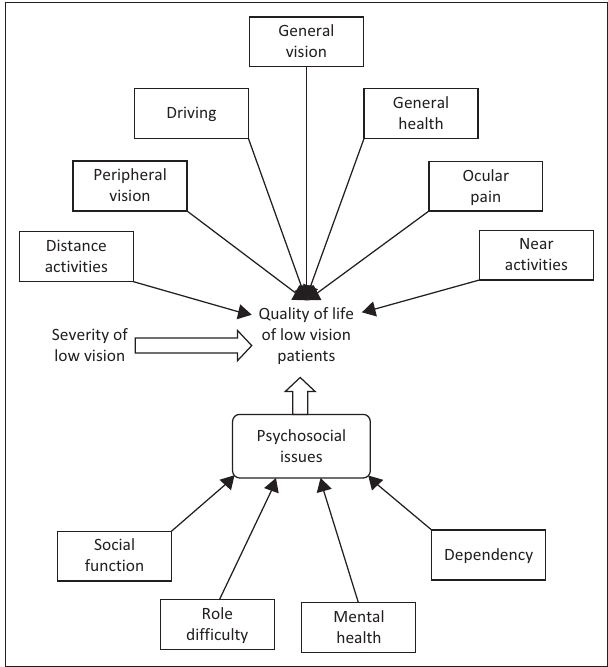
FIGURE 1: Psychosocial and vision-specific aspects of NEI VFQ-25